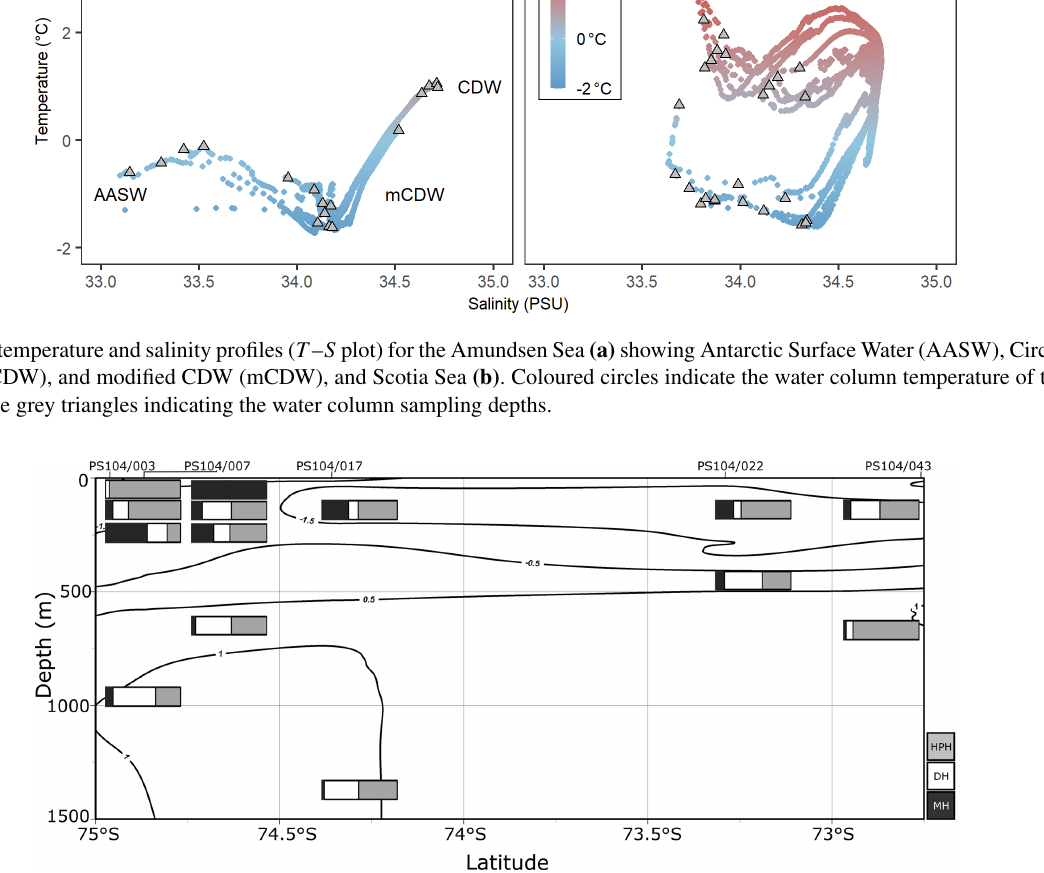
Figure 3. Relative abundance (%) of IPL-GDGTs at approximate sample depths in the Amundsen Sea. Bars reflect IPL-GDGT head group, with black representing MH head groups, white representing DH, and grey representing HPH. Contour lines show approximate ocean temperature ranges using CTD data taken at each sample station with Ocean Data View DIVA